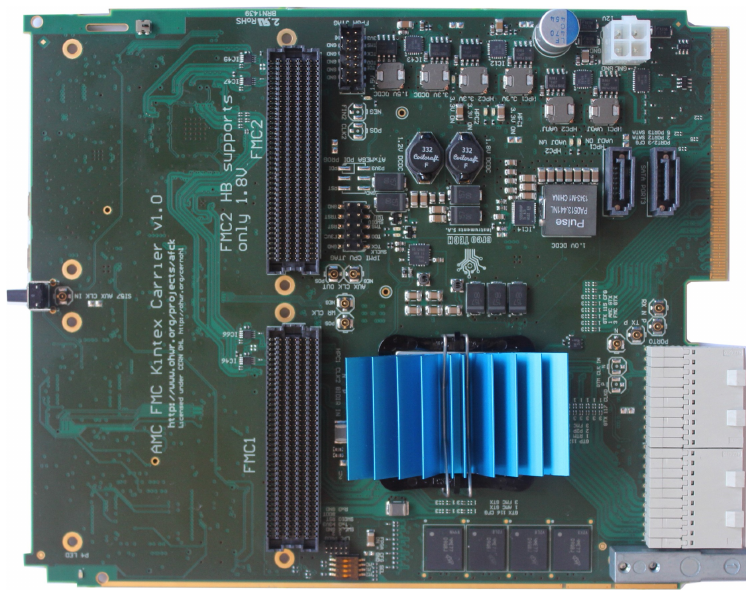
Figure 31. AMC FMC Carrier Kintex (AFCK)